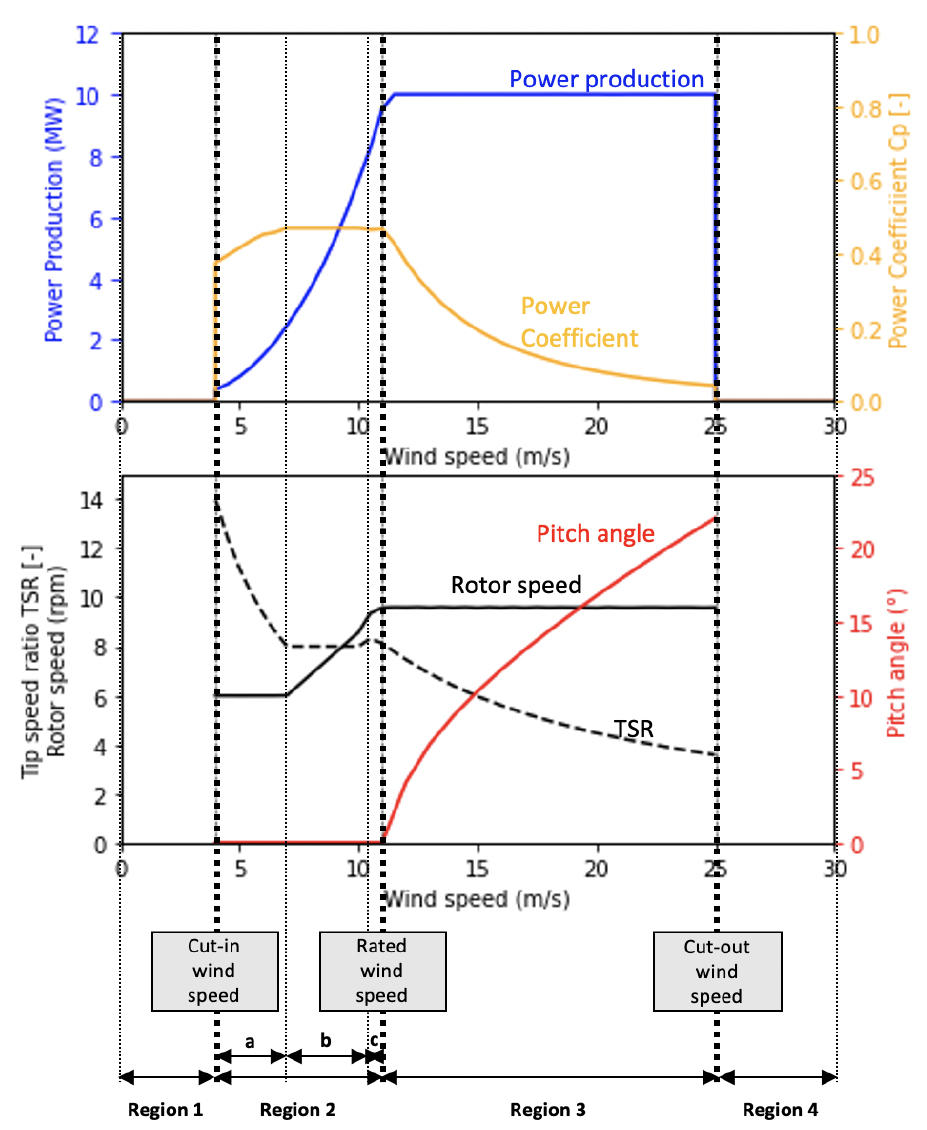
Figure 2. Operating regions and variation of the power, rotor speed, pitch angle and TSR. There are four regions of turbine operation for different wind speeds. In Region 1 (below the cut-in wind speed) there is no power produced, and the power coefficient is zero. Region 2 can be further divided into Regions 2a, 2b and 2c. These sub-regions can